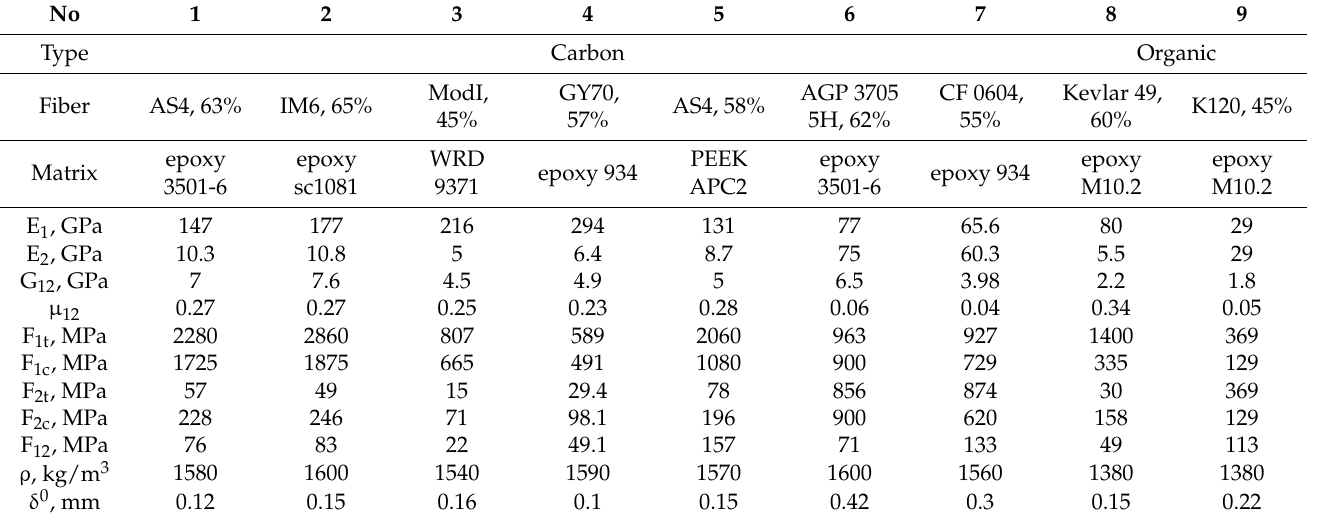
Table 2. Common carbon fiber-based and organic fiber materials.